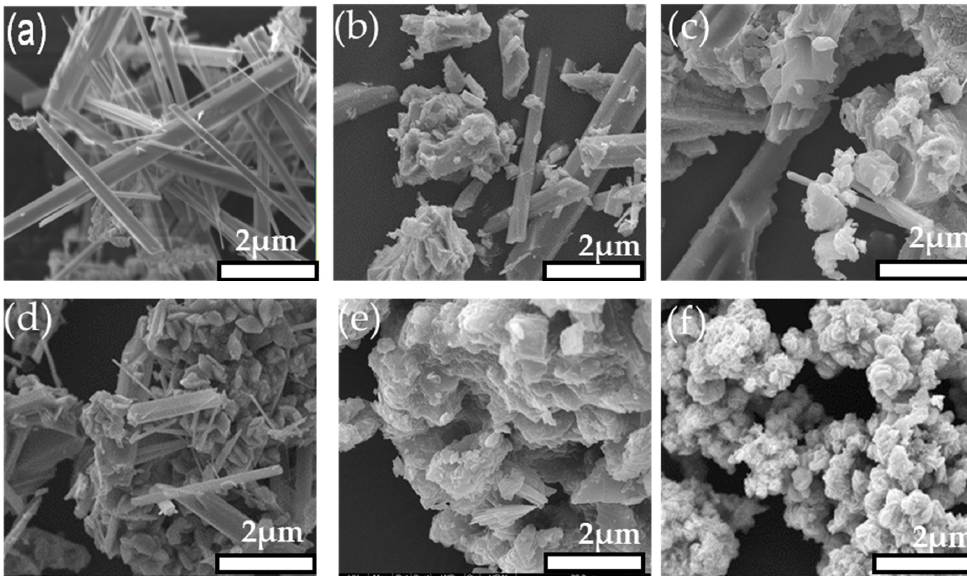
Figure 4. SEM images of Sb 2(1- x ) Fe 2 x S 3 powder prepared by the melt method for 1 h at 450 °C using different mole fractions of iron ( a ) x = 0 (b ) x = 0.2 ( c ) x = 0.4 ( d ) x = 0.6 ( e ) x = 0.8, and ( f ) x = 1.